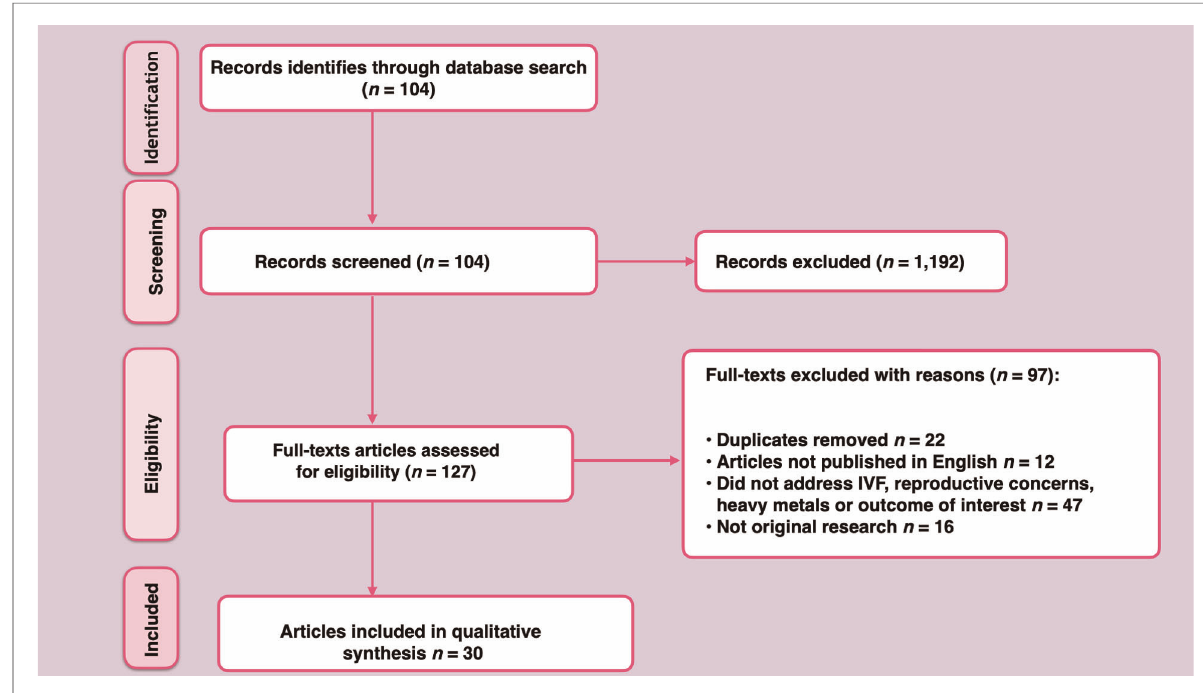
FIGURE 1 PRISMA fl ow diagram summarizing systematic search strategy and selection